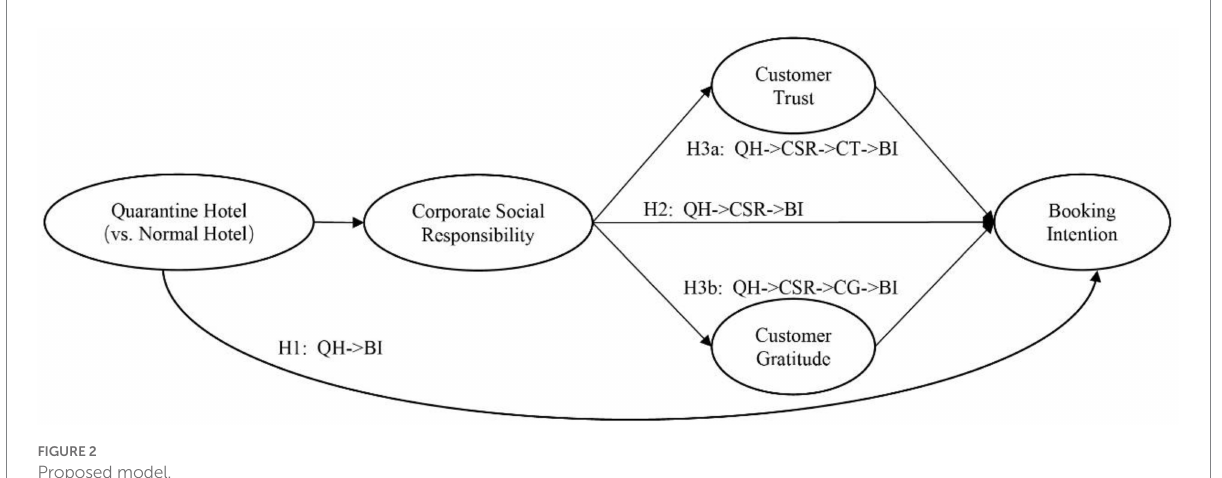
FIGURE 2 Proposed model.